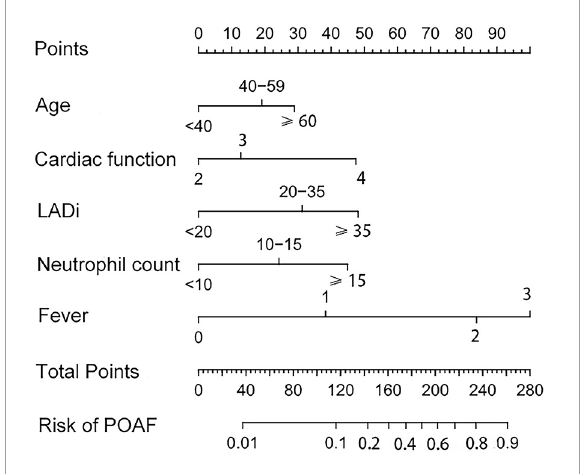
FIGURE1 The nomogram for predicting new-onset atrial fibrillation following isolated cardiac valve surgery. LADi, left atrial diameter